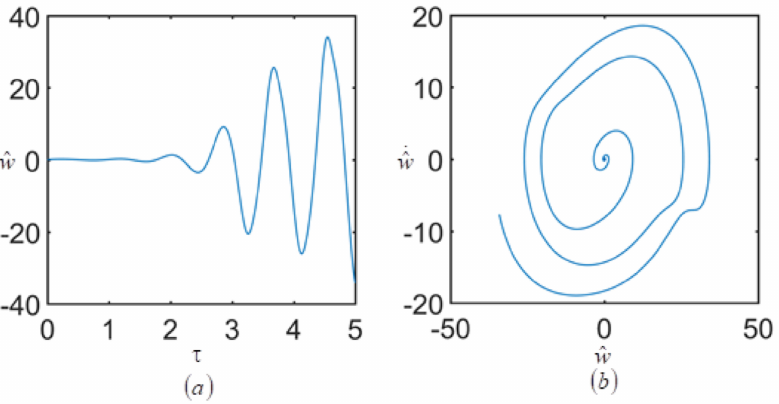
Figure 11. The linear response for the CFRP laminated cylindrical shell with an excitation frequency in the unstable region: ( a ) the time history on the plane ( τ , ˆ w ) , and ( b ) the phase portrait on the plane . ( ˆ w , ˆ w ) .